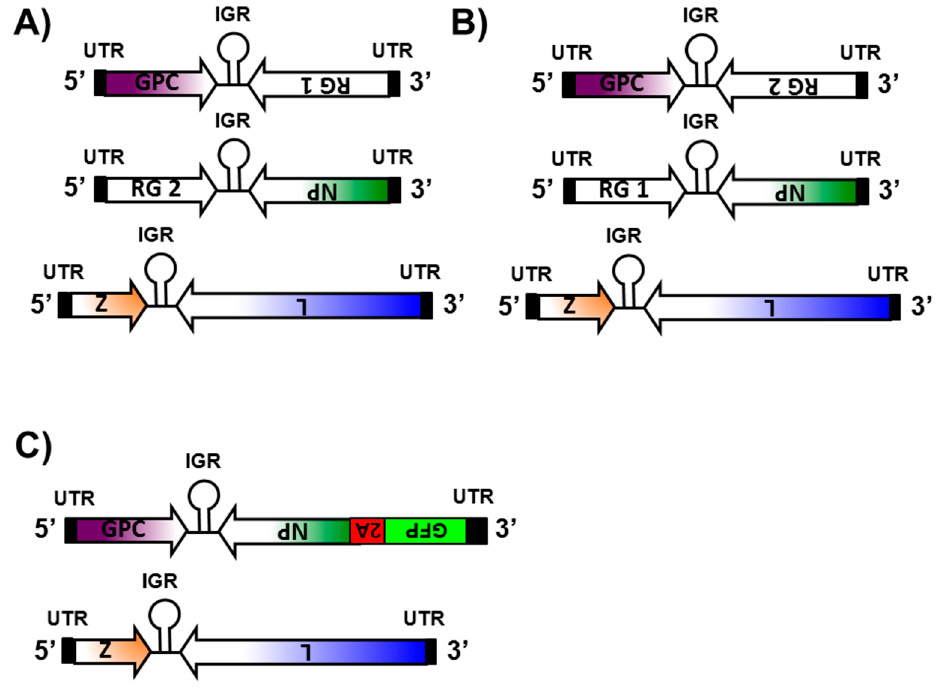
Figure 4. Reporter ‐ expressing recombinant arenaviruses. ( A , B ) R3 arenaviruses: For the generation of r3 arenavirus, the pPol ‐ I plasmid expressing the S vRNA segment is separated in two S plasmids. In the pPol ‐ I S1 plasmid, the viral NP is replaced by RG 1 and in the pPol ‐ I S2 plasmid, the viral GPC is replaced by RG 2 ( A ); alternatively, RG 1 can be expressed instead of the viral GPC in the pPol ‐ I S2 plasmid and RG 2 from the pPol ‐ I S1 plasmid instead of the viral NP ( B ). Regulation of RG expression depends on their location in the S segment. Expression of an RG in the NP locus is higher than that observed when the RG is located in the GPC locus. The physical separation of the GP and NP proteins into two different S segments (S1 and S2) represents a strong selective pressure to maintain a virus capable of packaging one L segment and two S segments; ( C ) recombinant bicistronic arenaviruses: In the bicistronic rLCMV/GFP ‐ P2A ‐ NP, the NP open reading frame in the pPol ‐ I S plasmid is replaced by the GFP ‐ P2A ‐ NP sequence that contains GFP tagged to the N terminus of NP, separated by the PTV1 2A peptide sequence (P2A). The P2A sequence allows for production of both GFP and NP from the same bicistronic mRNA transcribed from the NP locus of the S genome segment. Untranslated regions (UTR, black boxes) and intergenic regions (IGR) in each of the vRNA L and S segments are indicated.